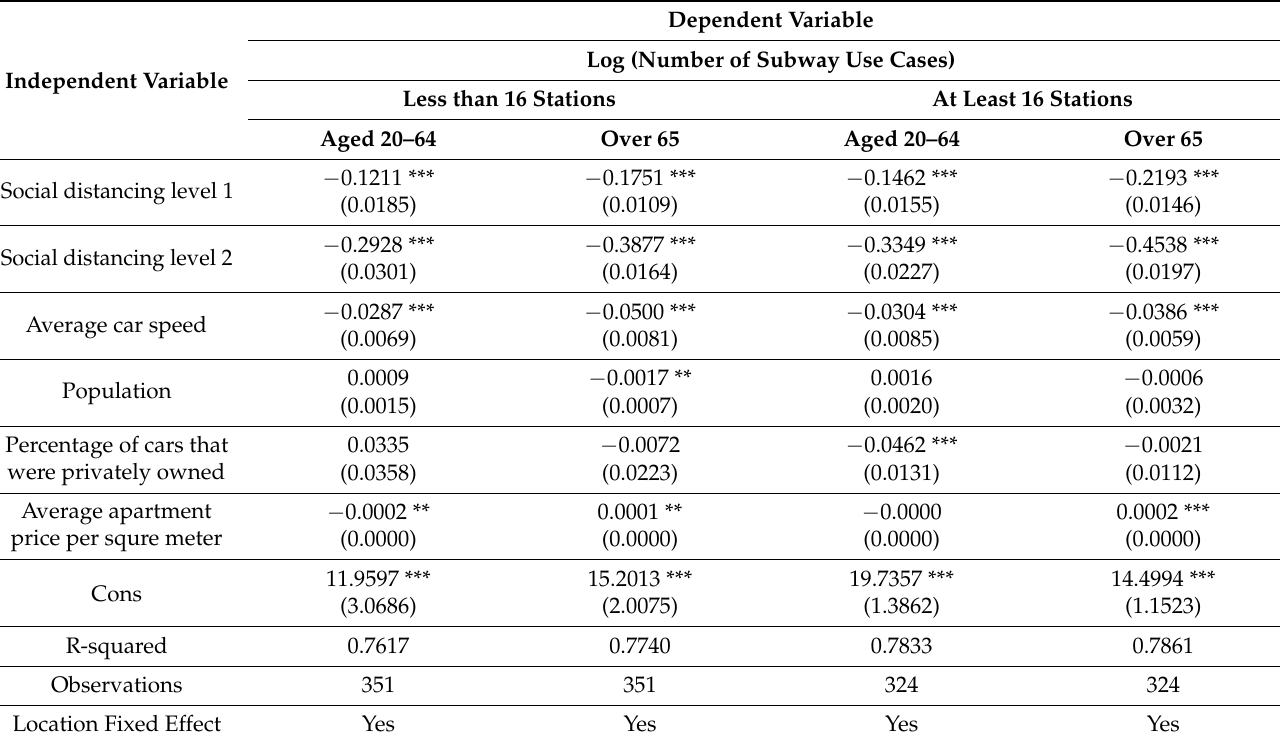
Table 3. Panel results: change in the subway use demand with respect to the number of subway